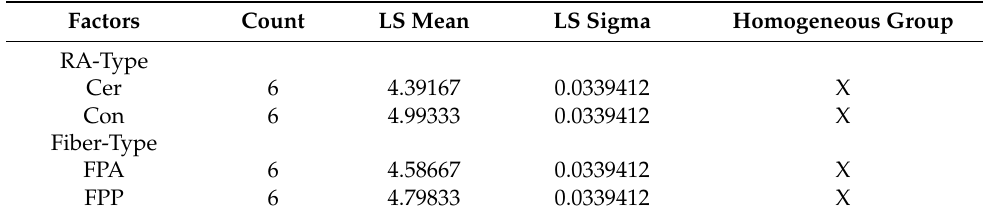
Table 10. Multiple range tests for Flexural Strength (MPa).